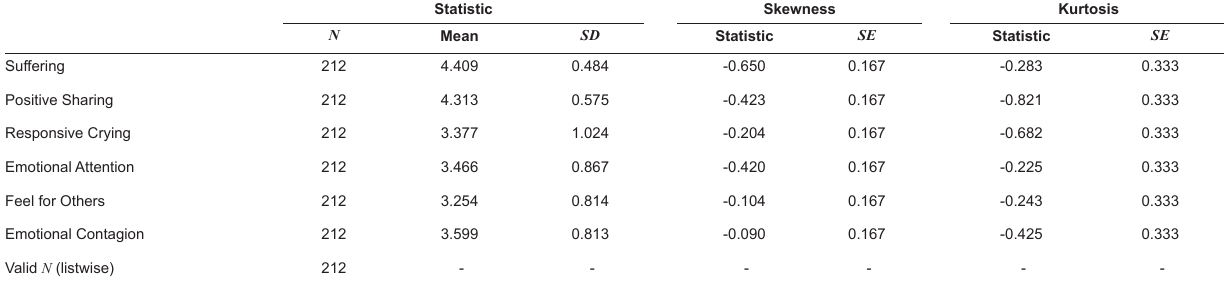
TABLE 3 Descriptive statistics for the Multi-dimensional Emotional Empathy